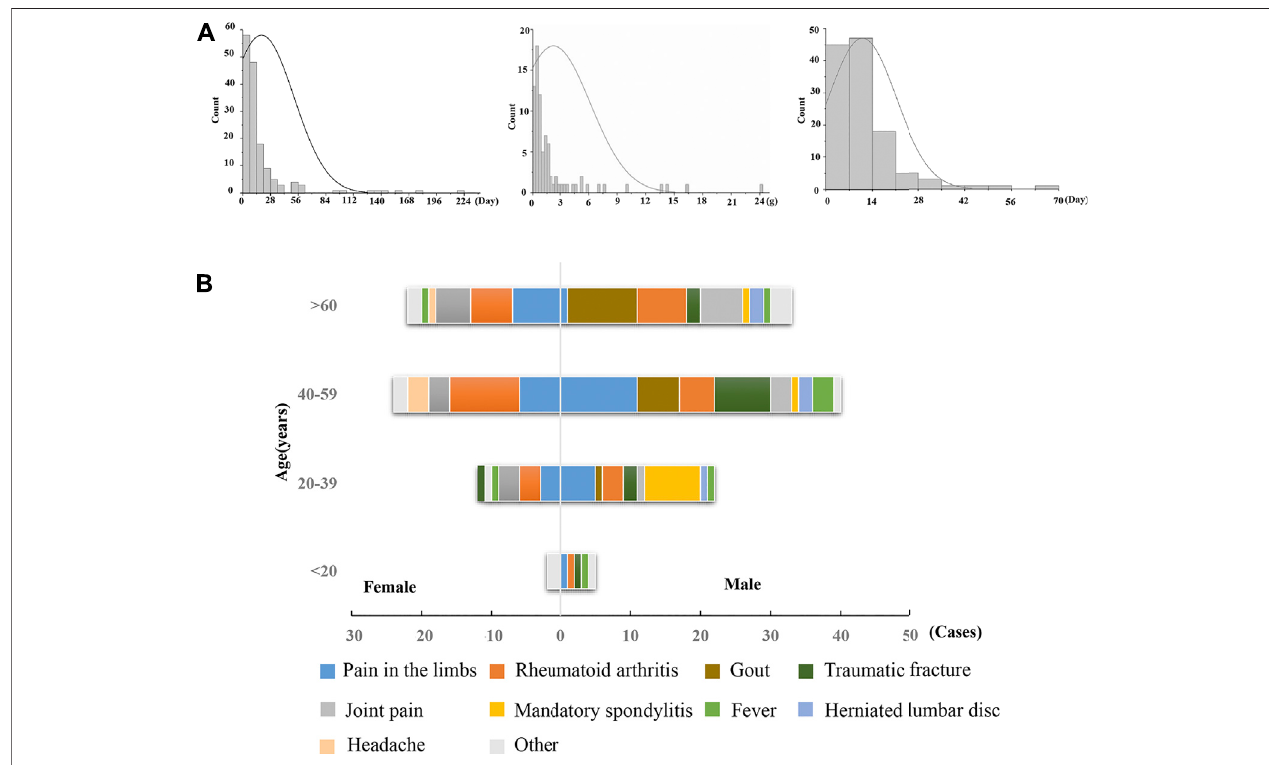
FIGURE1| CharacteristicsofDicl-relatedhepatobiliaryADR. (A) TimeofhepatobiliaryADR,accumulateddose,andimprovementtimeofDicl-relatedhepatobiliary ADR. (B) Sex, age, and underlying complications of Dicl-related hepatobiliary ADR.